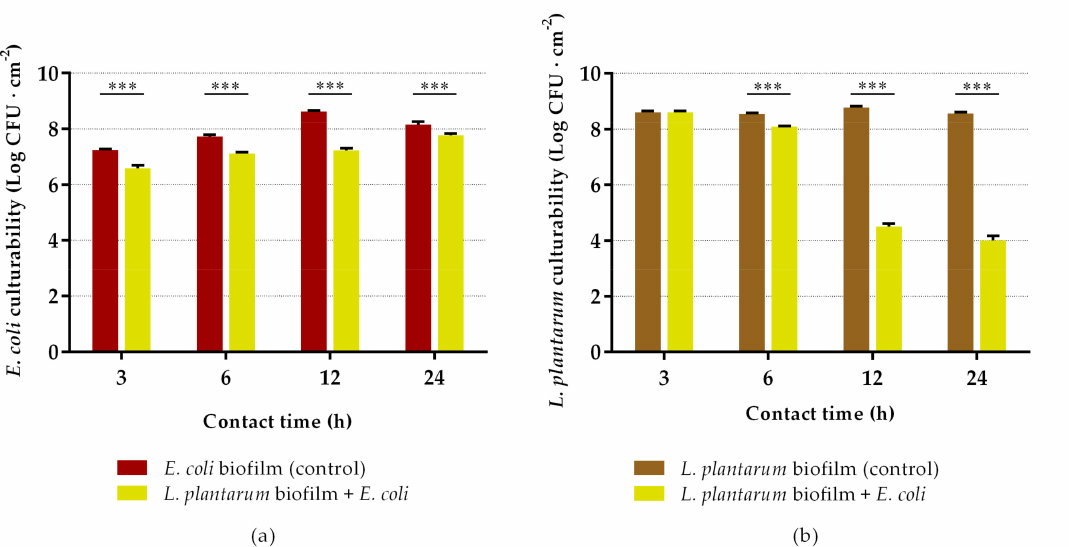
Figure 3. Culturability of E. coli ( a ) and L. plantarum ( b ) after 3, 6, 12 and 24 h of contact between the pre-formed probiotic biofilm and the pathogen. The biofilms of L. plantarum were formed for 48 h on silicone coupons under quasi-static conditions in MRS broth at 37 ◦ C with medium replacement. E. coli was subsequently added to the wells for 3, 6, 12 and 24 h under quasi-static conditions in AUM at 37 ◦ C. The culturability of L. plantarum and E. coli cells in the biofilm was determined by colony-forming units (CFU) counts. The data present the mean and standard deviation (SD) of at least three independent experiments. Statistically significant differences between the control and exposure were considered for p -values < 0.05 (*** indicates p <